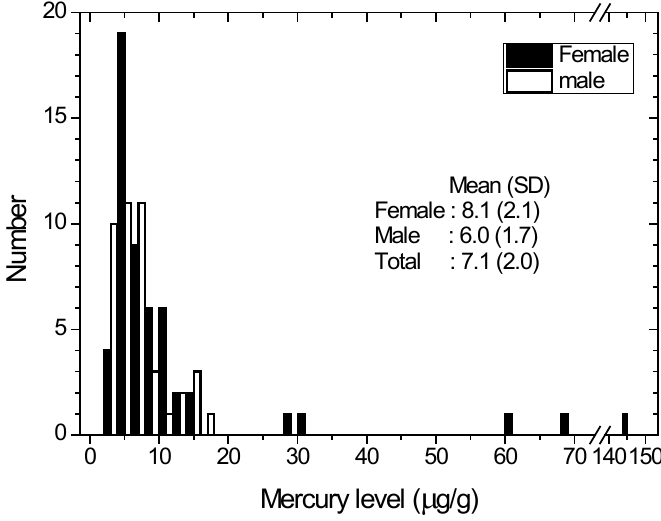
Figure 2. Distribution of the hair mercury among the total population. Open bar and solid bar indicate male and female, respectively. Geometrical mean and Standard Deviation are shown for male, female and